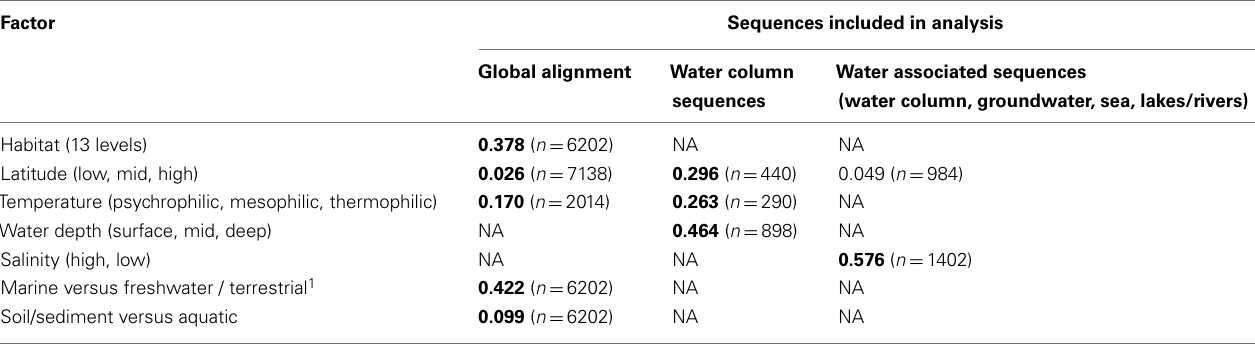
TableA2 | R values for factors tested viaANOSIM for association with variation in archaeal amoA sequence diversity.